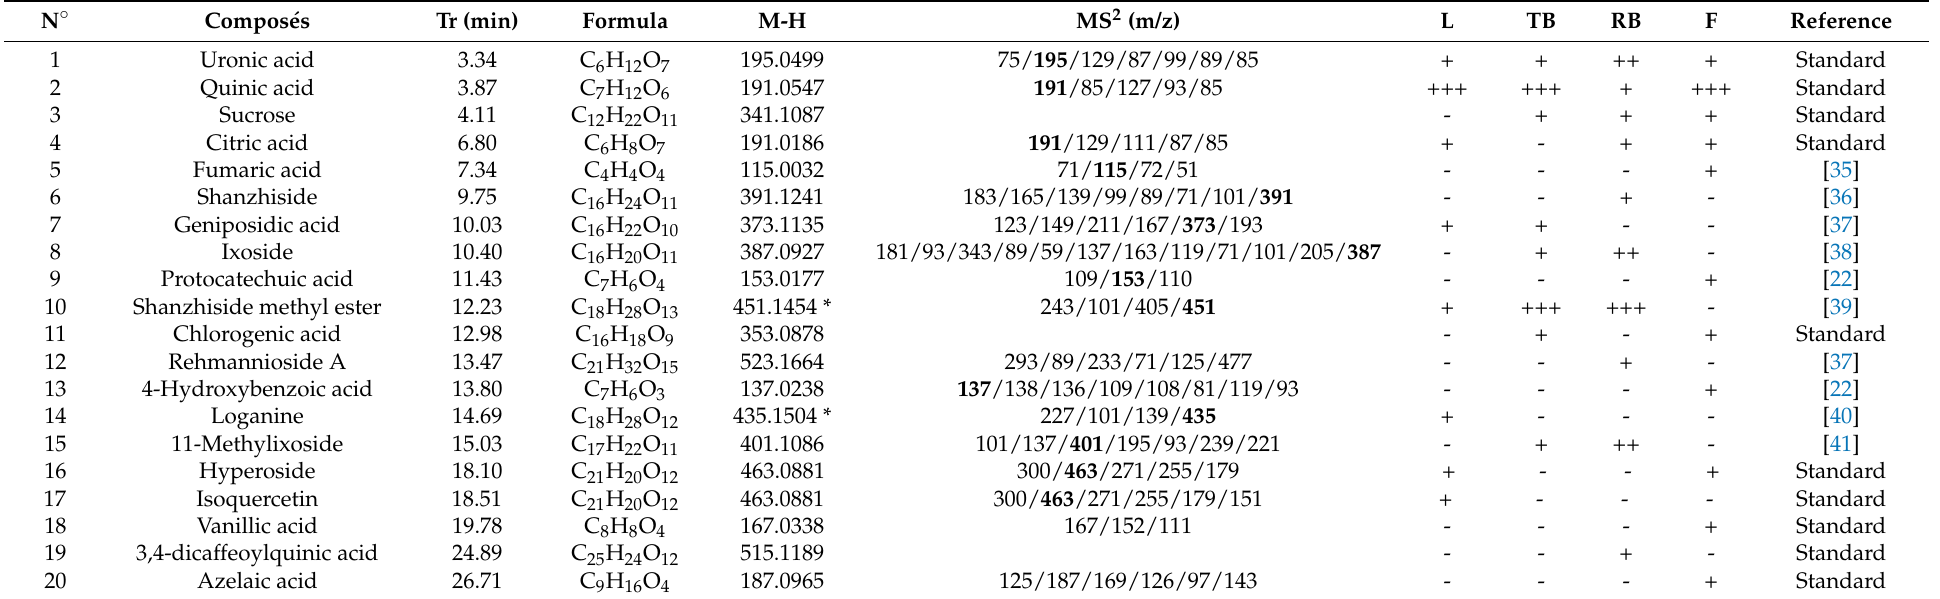
Table 2. Compounds identified in extracts of leaves, trunk bark, root bark and fruits of Crossopteryx febrifuga